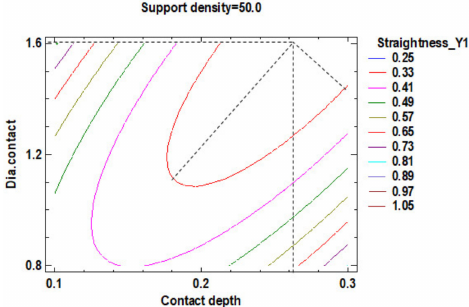
Figure 24. Contours of Estimated Response Surface for Straightness_Y1 and centre support density. Contour Y2